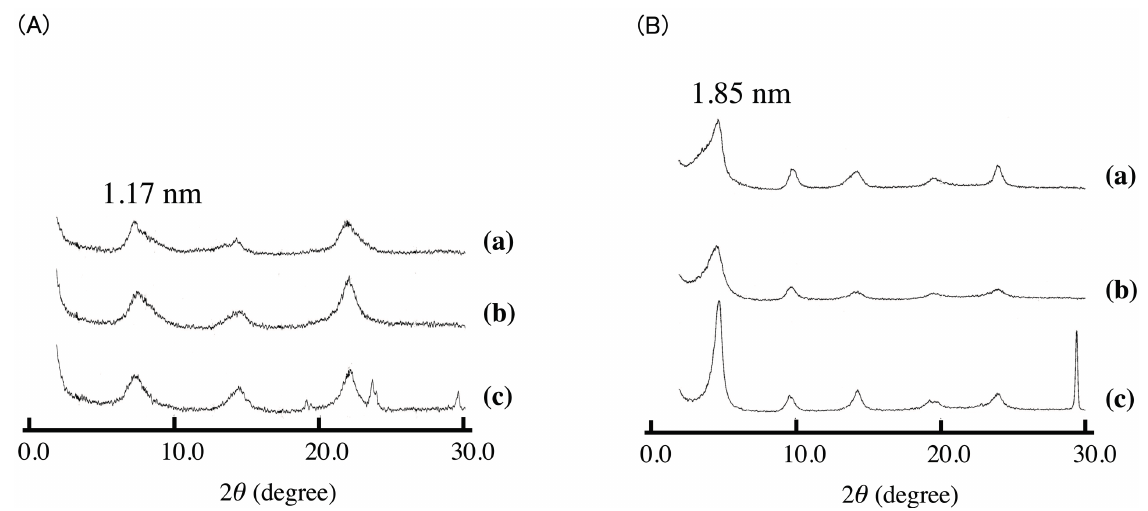
). ( a ) is the XRD pattern of sample synthesized in aqueous solution, intercalated LDH(NO 3 and ( b ) and ( c ) are XRD patterns of samples synthesized under solid condition. ( b ) and ( c ) are XRD patterns after and before washing sample with